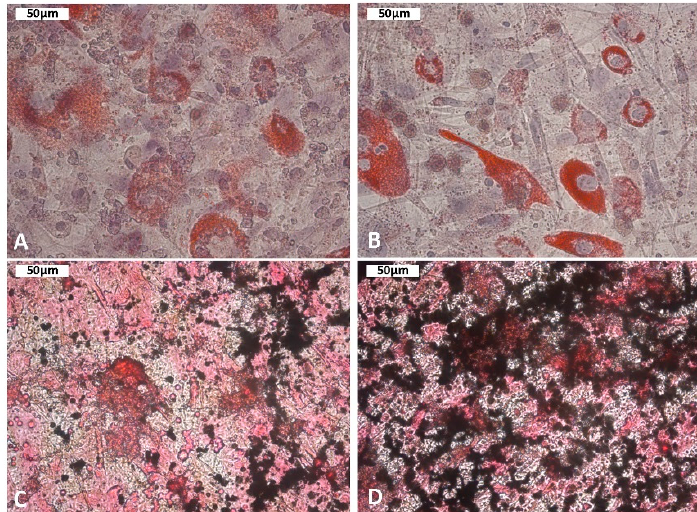
Figure 1. Proof of multipotency. Human mesenchymal stem cells’ (hMSCs) differentiation towards osteogenic and adipogenic lineages was compared with those cultivated in DMEM-EM ( A , C ) and plasma ( B , D ). The adipogenic differentiation was confirmed with the Oil Red O staining ( A , B ), showing lipid droplets as red spots. The osteogenic differentiation was confirmed with the Van Kossa staining ( C , D ), showing calcium deposits as dark dots.